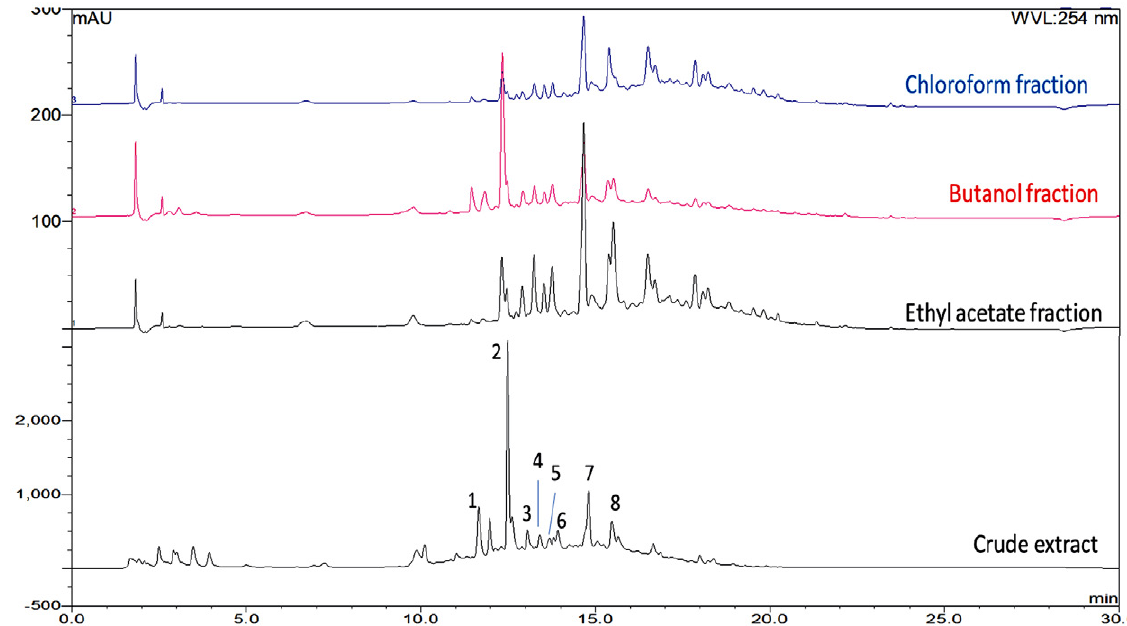
Figure 4 . Chromatograms of Eurycoma longifolia extract and its organic fractions; ethyl acetate, butanol and chloroform. Peak 1-8 have been as- signed in Suppl. Mat. Table